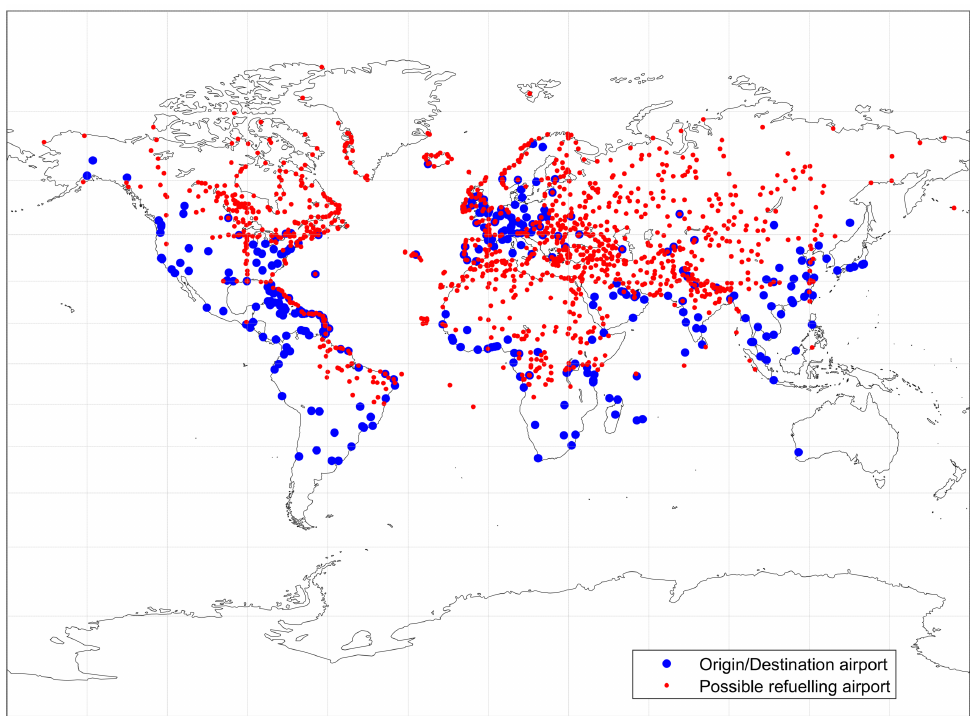
Figure 2. Global distribution of considered